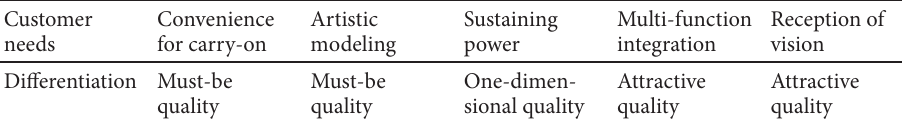
Table 1. The priority of customer needs with differentiation from Kano model Customer needs Differentiation Must-be